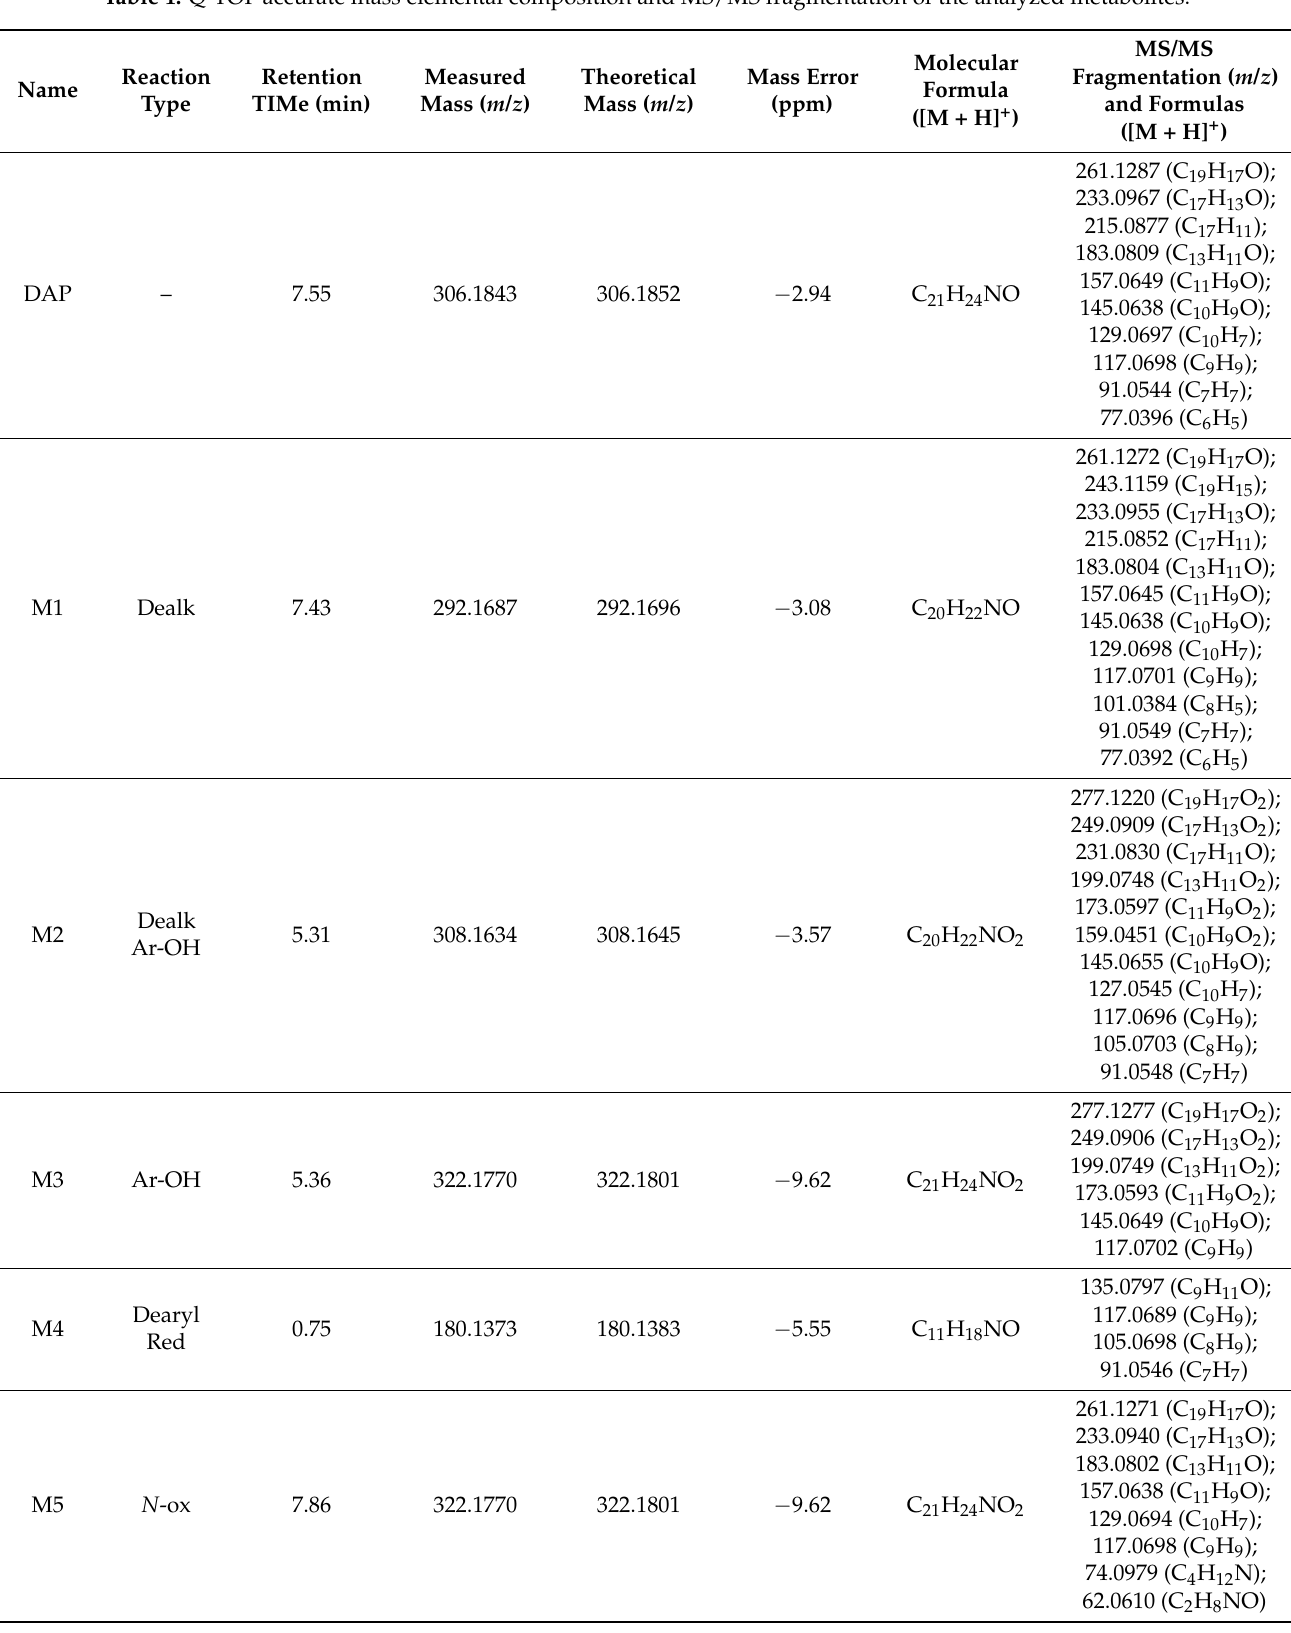
Table 1. Q-TOF accurate mass elemental composition and MS/MS fragmentation of the analyzed